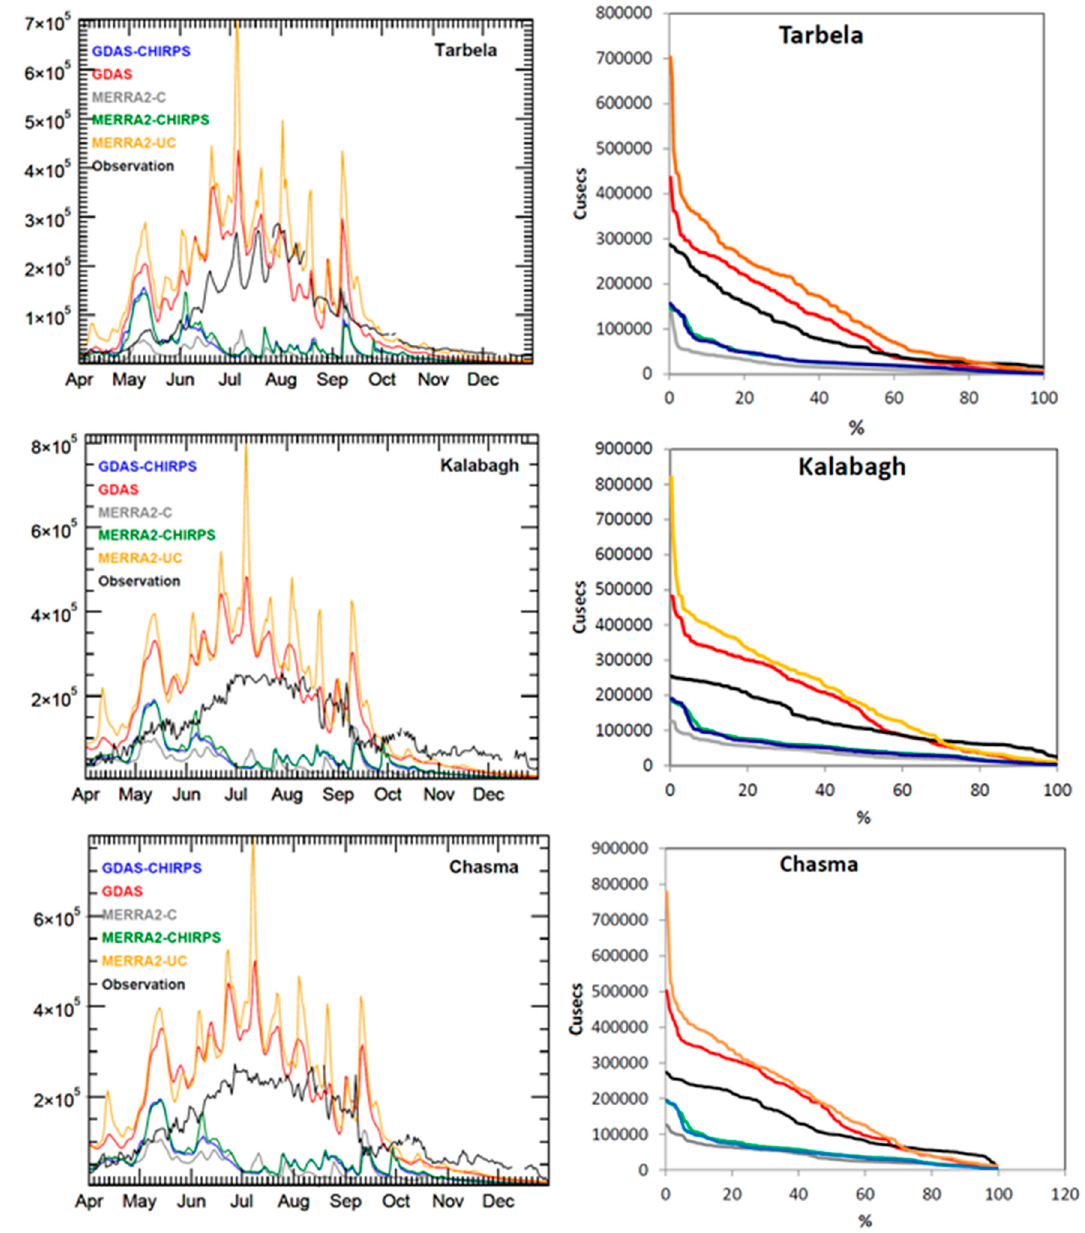
Figure 8. Comparison between the observed (black line) daily streamflow in 2014 and the modeled streamflow with meteorological forcing from GDAS-CHIRPS (Blue), GDAS(Red), MERRA2-C (grey), MERRA2-CHIRPS (green), MERRA2-UC (Orange) for Tarbela ( top left ), Kalabagh ( middle left ), and Chasma ( bottom left ). The same color scheme is used to plot the duration curve for the streamflow from multiple meteorological forcing for the same three stations ( right column ). Unit in y axis is cusecs and x axis is %. The duration curves show the probability that a given flow will be equaled or exceeded the percentage of time.